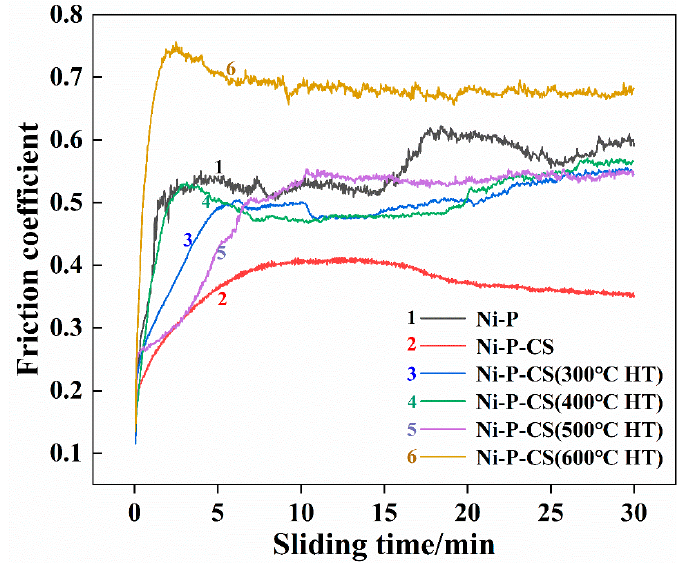
Figure 10. The friction coefficients of different coatings.